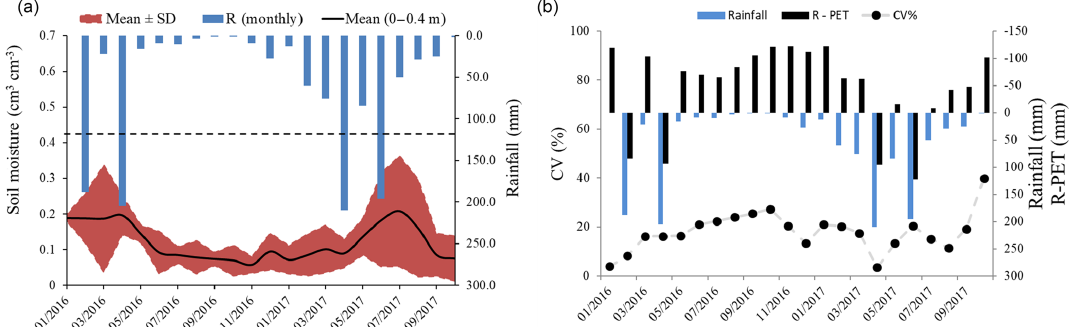
Figure 7. Monthly rainfall and mean soil moisture for the 0–0.40m layer. One standard deviation interval around the mean value for the 0–0.40m layer, also showing the mean soil moisture at the field capacity (dashed line) (a) ; time series for the coefficient of variation of the mean soil moisture, and the net rainfall (R-ET) values (b) .